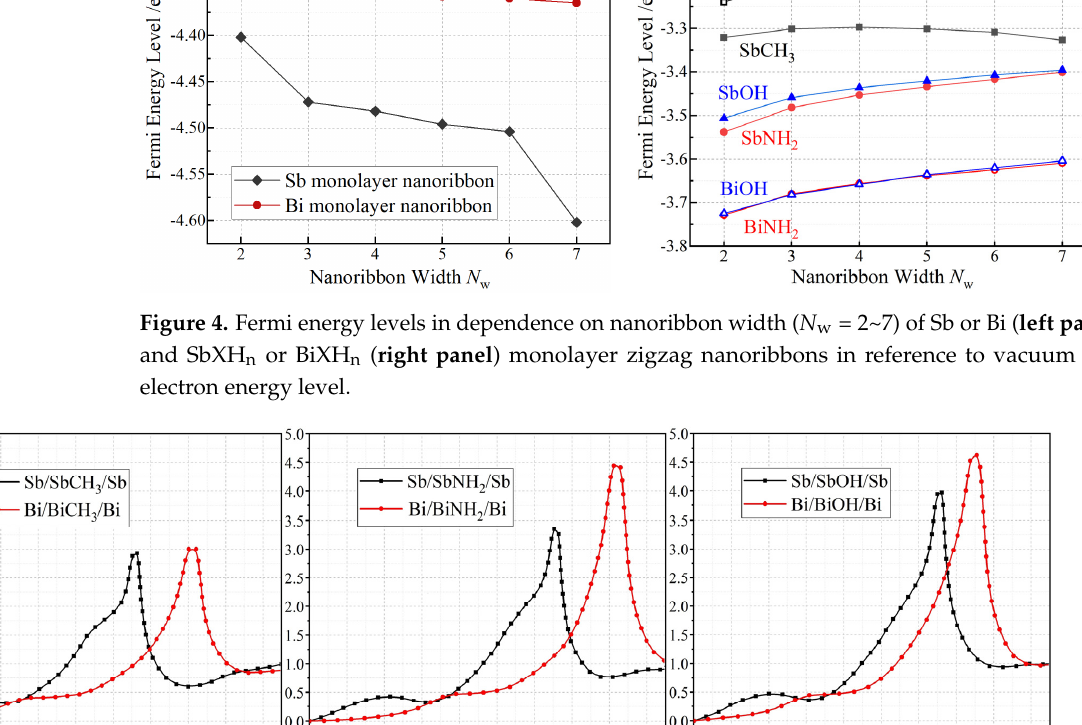
Figure 5. Quantum conductance I-U b characteristics of resonant tunneling transistors modeled by Sb/SbXH n /Sb and Bi/BiXH n /Bi double-heterostructures of monolayer zigzag nanoribbons.